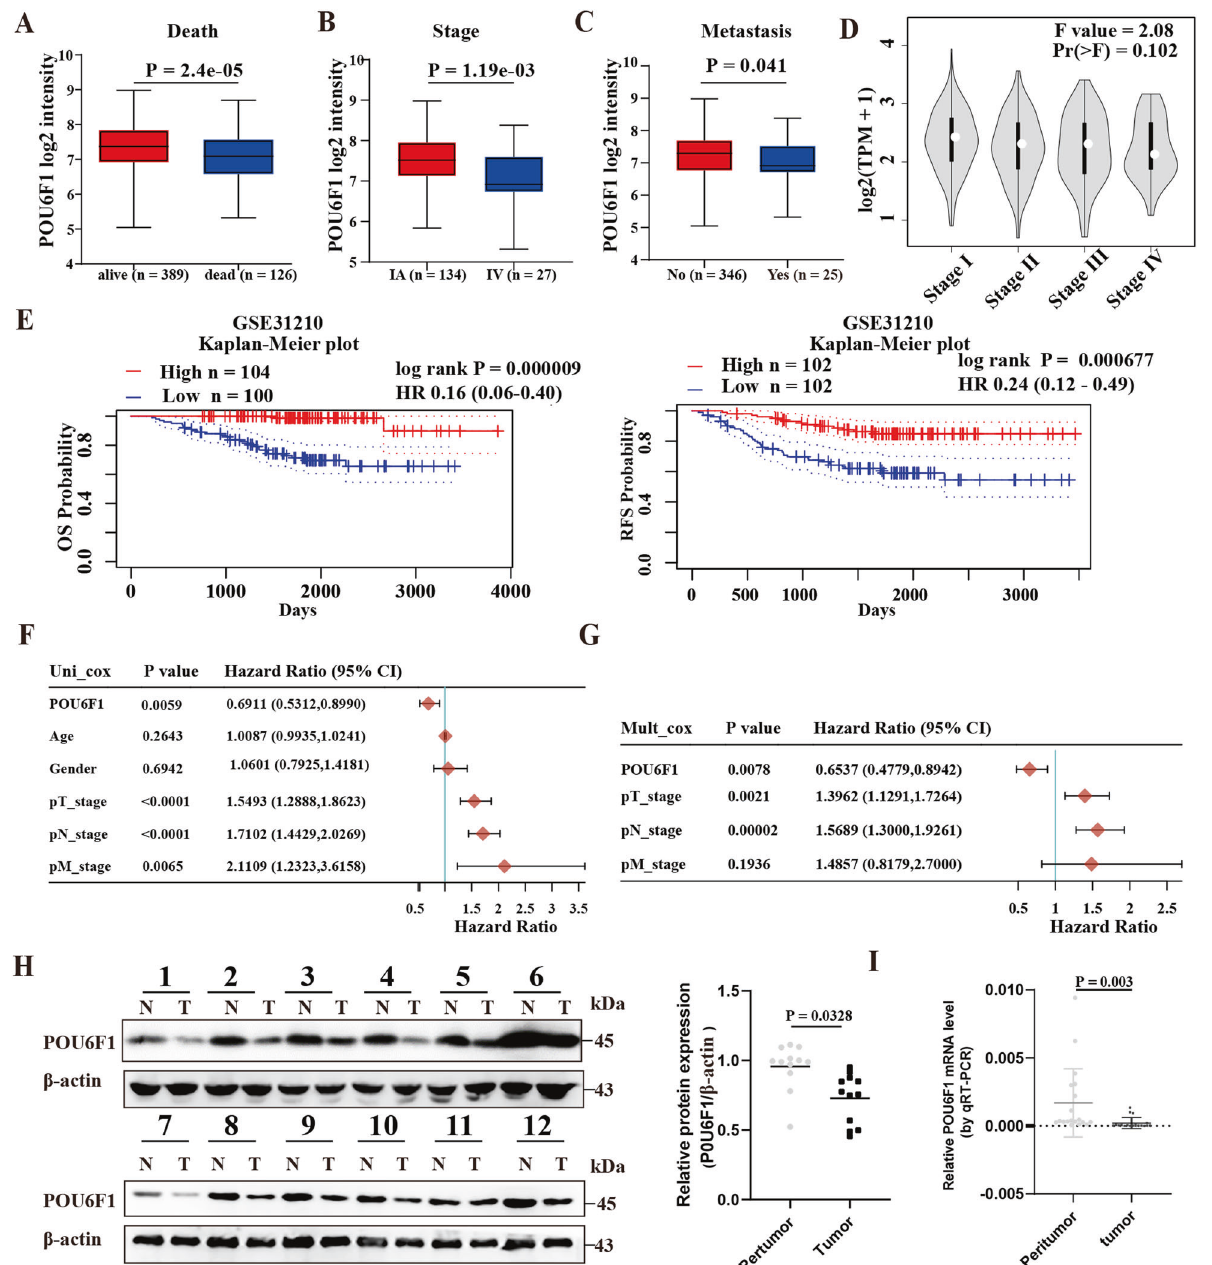
Fig. 2 POU6F1 is downregulated and predicts poor prognosis in LUAD patients. A – C Mining the public dataset (LUAD-TCGA) showing the differential expression of POU6F1 in LUAD patients with different status of death ( A ), stage ( B ), and metastasis ( C ). D Homogeneity of variance analysis revealing the trend of POU6F1 expression in different tumor stages of LUAD patients. E Kaplan – Meier survival curve indicating overall survival (OS) and relapse-free survival (RFS) of LUAD patients with high or low levels of POU6F1 in the GEO dataset (GEO31210). F , G Pooled hazard ratios (HRs) based on univariate analysis ( F ) and multivariate analysis ( G ) for assessing the prognostic value of POU6F1 in LUAD patients. H Western blotting assay showing the expression of POU6F1 in human LUAD tissues and adjacent normal tissues ( n = 12). Relative expression ( H right panel) of POU6F1 was normalized to that of β -actin using ImageJ software. I Real-time qRT-PCR assay showing the expression of POU6F1 in LUAD tissues and adjacent normal tissues ( n = time qRT-PCR showed the downregulation of POU6F1 in LUAD tissues (Fig. 2H, I). In summary, those results indicated that POU6F1 was signi fi cantly underregulated in LUAD tissues and maybe suppressive.